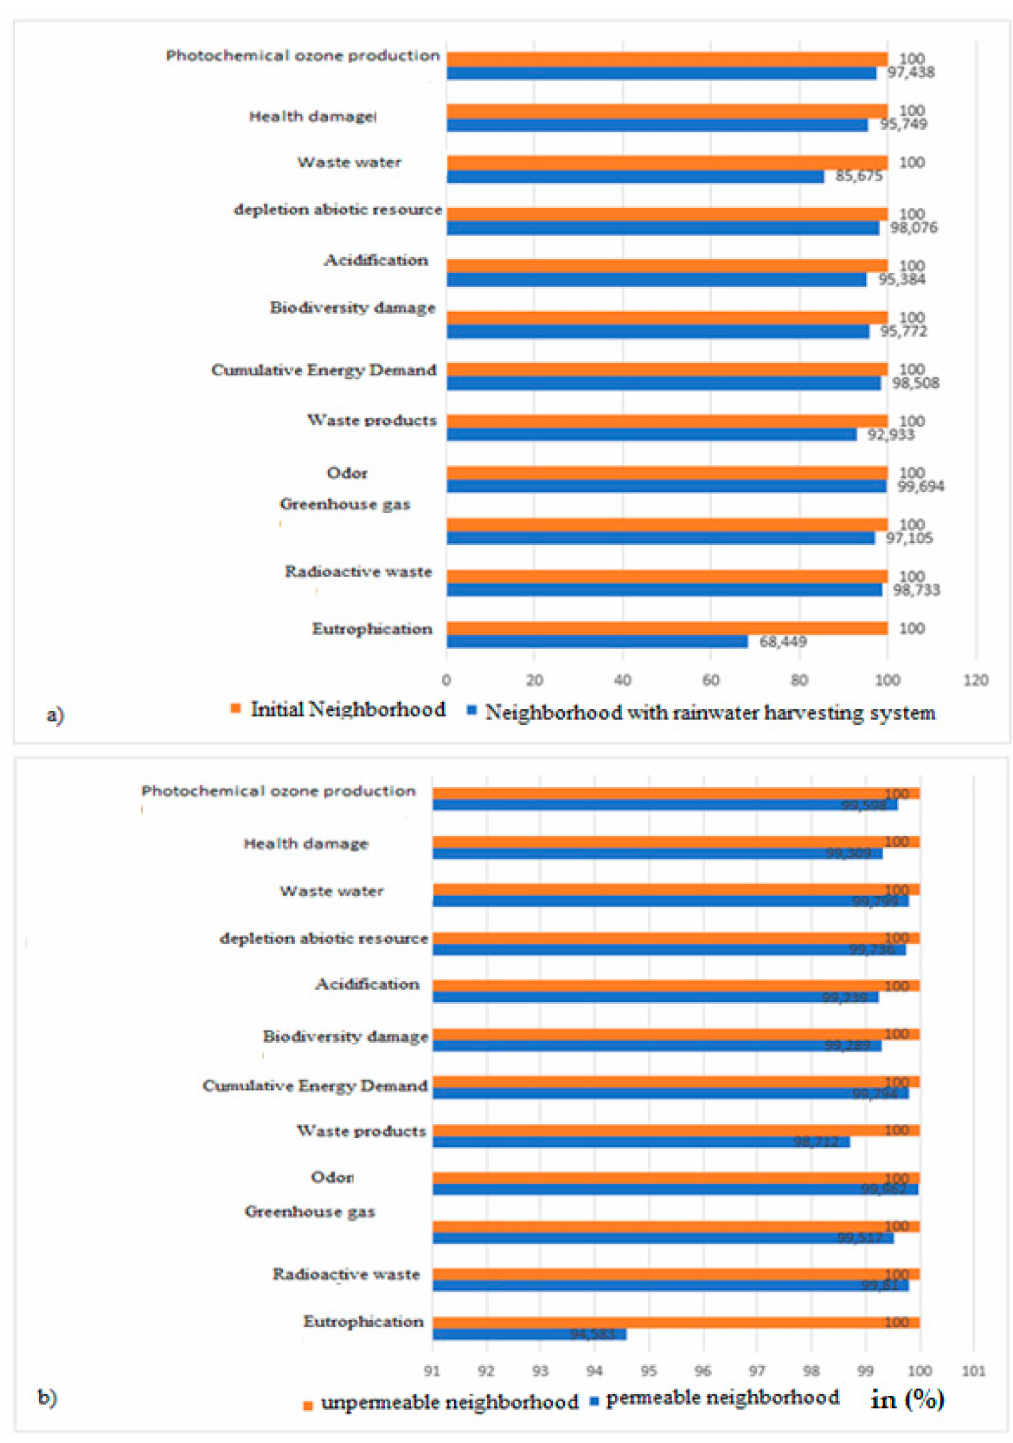
Figure 9. Comparative diagram of the environmental impacts of scenarios with and without rainwater harvesting systems ( a ), and with and without permeable floor coverings ( b ) (functional unit: entire neighborhood), in